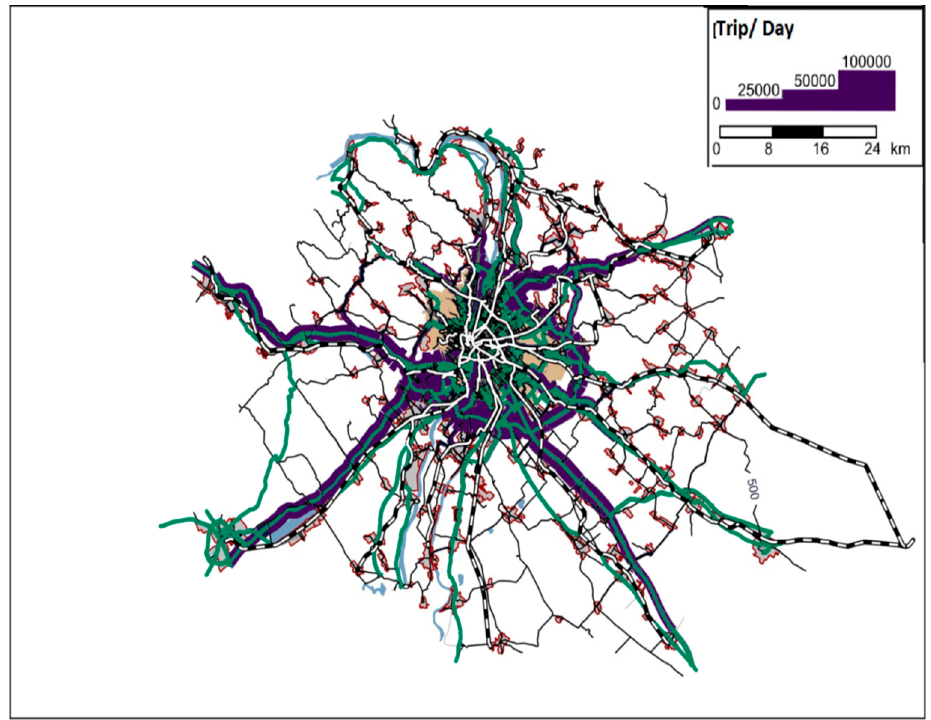
Figure 1. Budapest city EFM model.